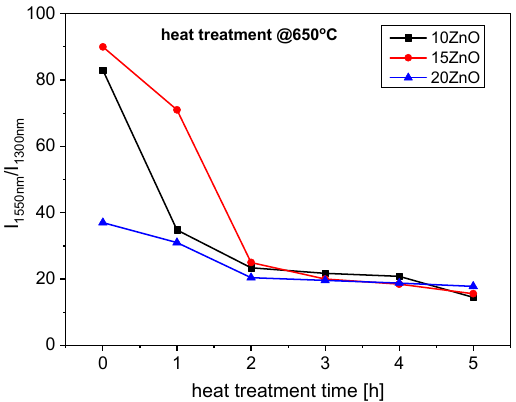
Figure 10. Infrared luminescence spectra of 0.1NiO/0.1Er 2 O 3 co-doped GGK glass and transparent glass-ceramics with ( a ) 15 ZnO (mol.%), ( b ) 20 ZnO (mol.%), (HT@650 °C for 1–5 h), λ exc = 808 nm.